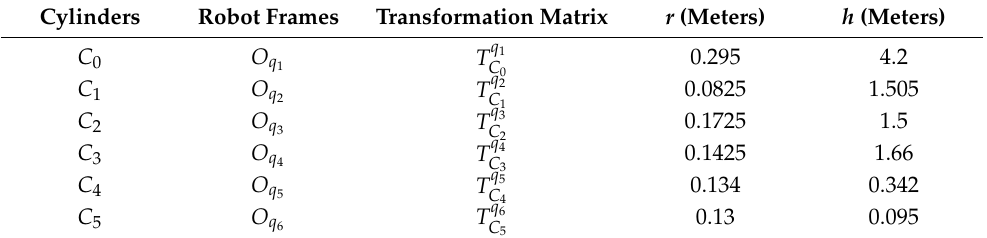
Table 1. Parameters of the cylinders.